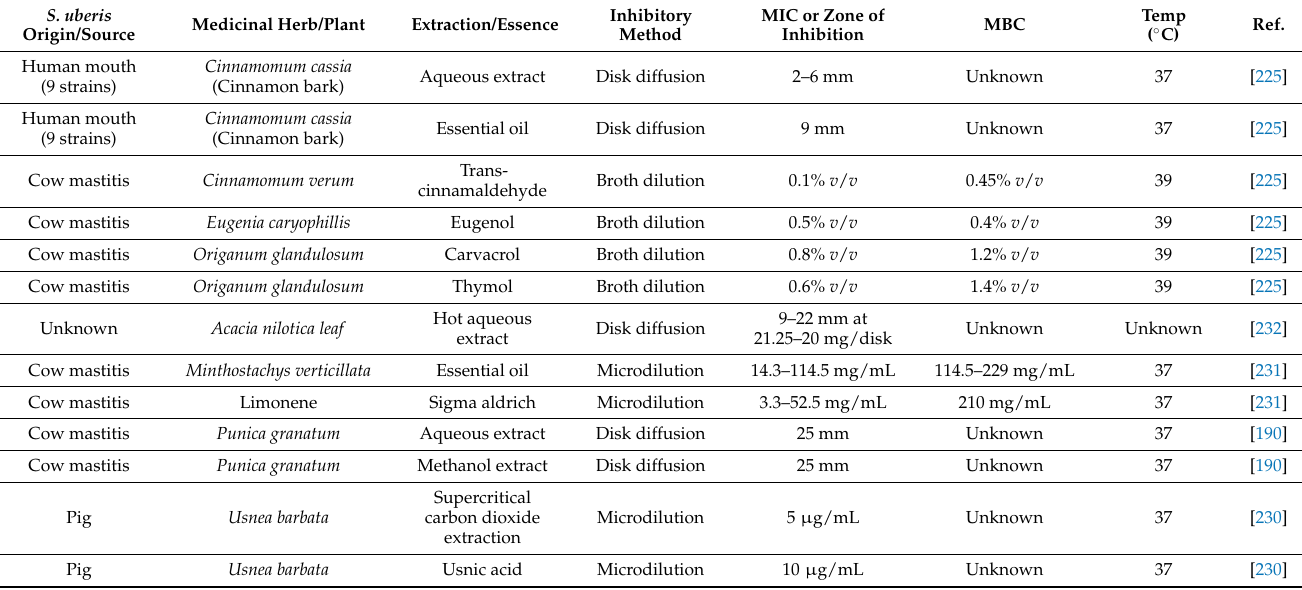
Table 7. In vitro inhibitory activity of medicinal /plants to S.